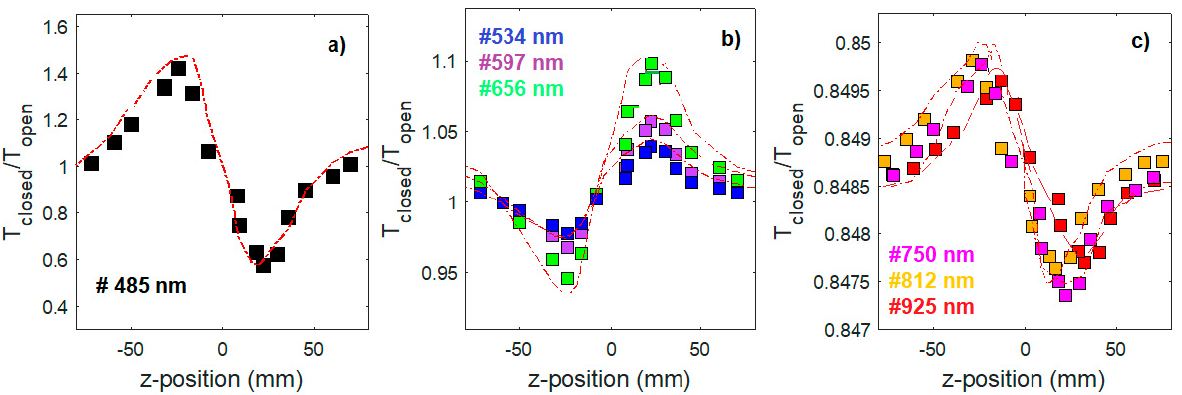
Figure 6. Z-scan profiles in the closed/open aperture configuration for ( a ) sample #485 nm; ( b ) sam-ples #534 nm, #597 nm, #656 nm; ( c ) samples #750 nm, #812 nm, 925